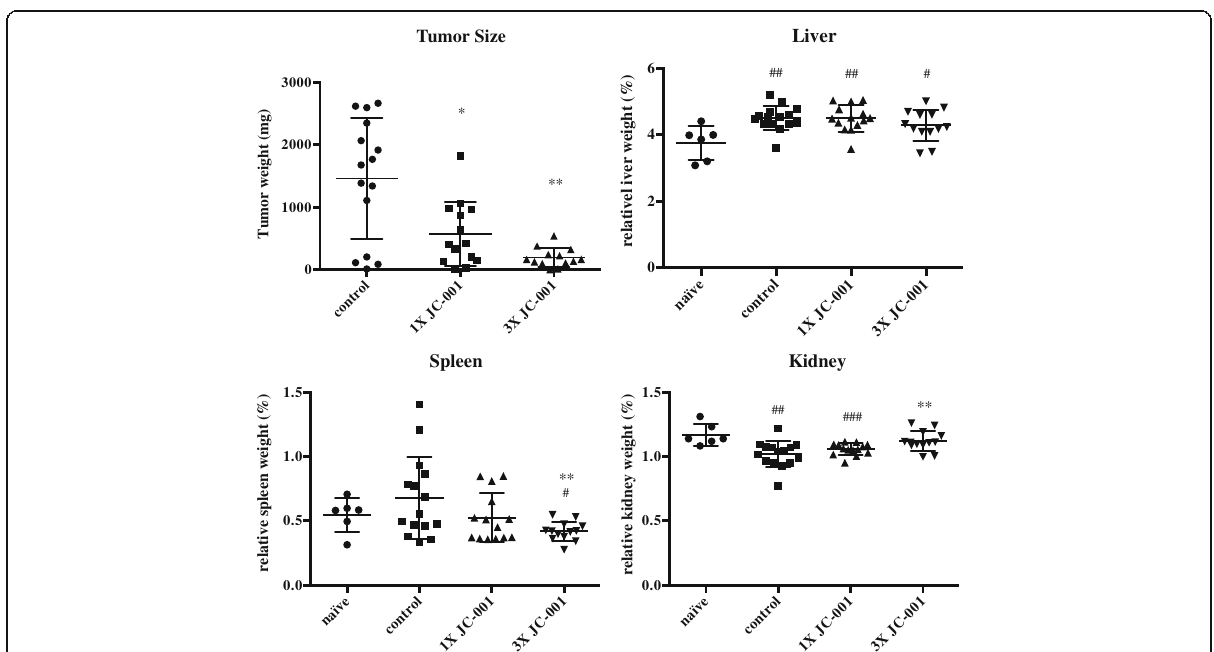
Fig. 2 JC-001 inhibits tumor growth and prevents organ damage in LLC1-inoculated C57BL/6 immunocompetent mice. After LLC1 tumor growth for 23 days, the average tumor weight in the control group reached 1461 mg, and the relative organ weights differed from those in the naïve group. The average tumor weight in the 3X JC-001-treated group was significantly reduced to 193 mg. * p < 0.05, ** p < 0.01, *** p < 0.001 compared with the control group. # p < 0.05, ## p < 0.01, ### p < 0.001 compared with the naïve